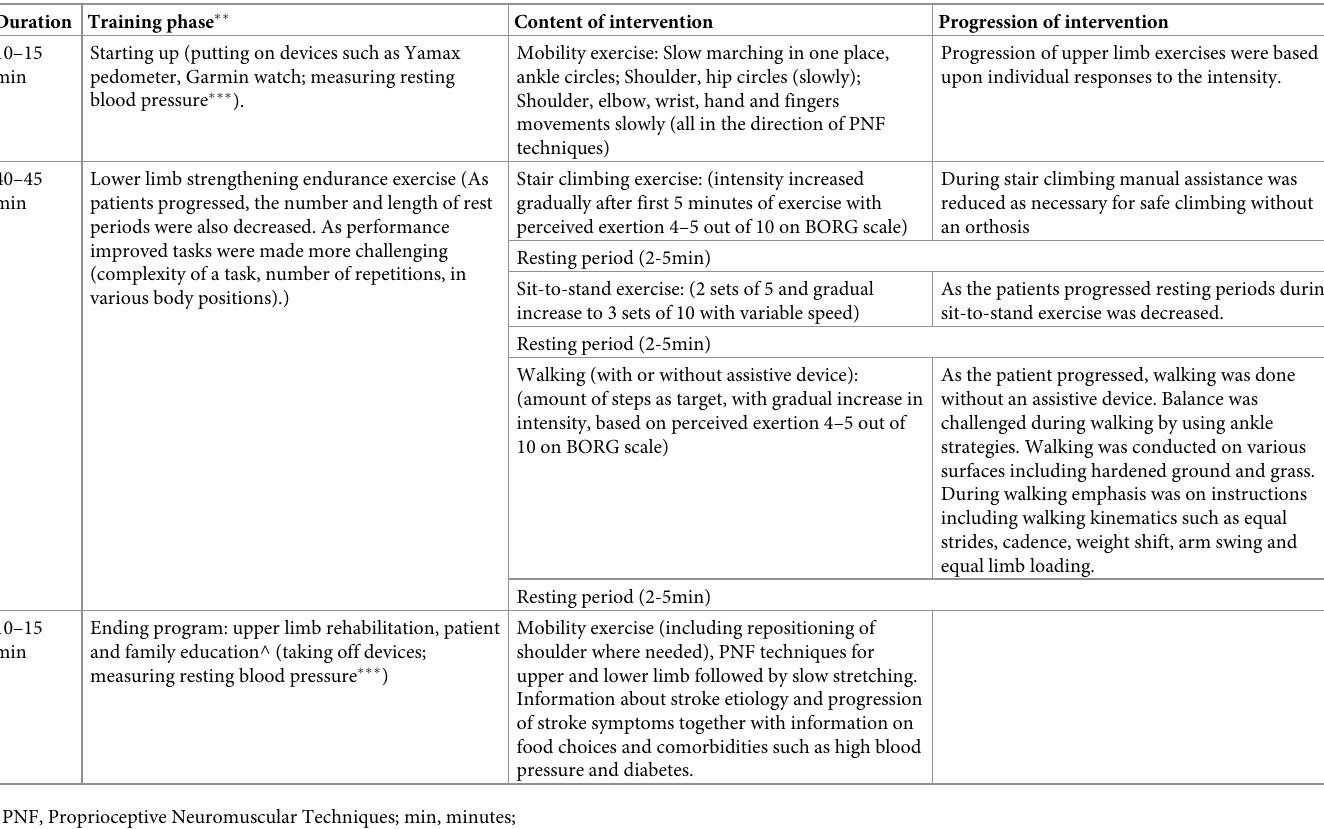
Table 1. Overview intervention